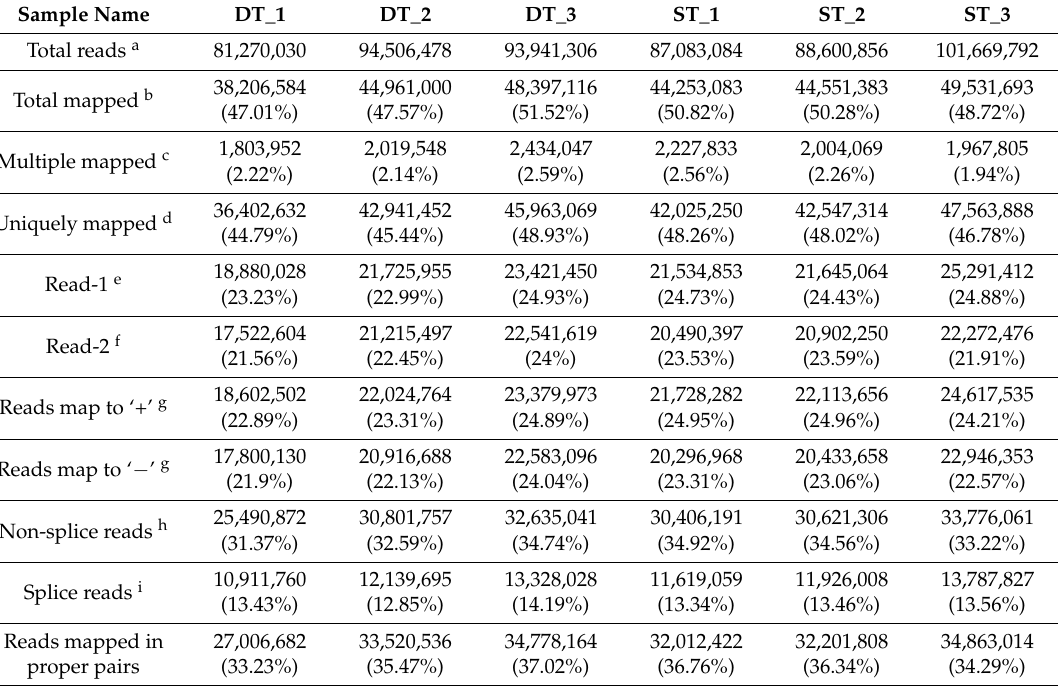
Table 2. Sequence alignment results of reads mapped to the reference